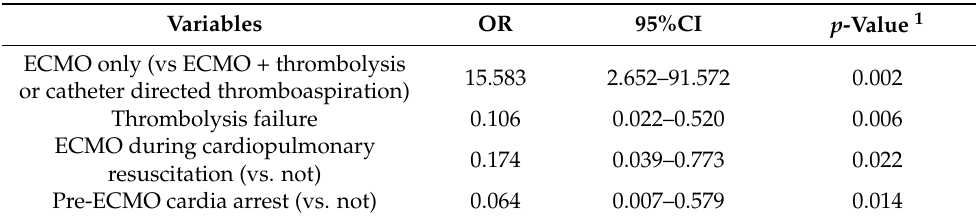
Table 4. Variables independently associated with 30-day survival status among ECMO-treated patients for massive PE.